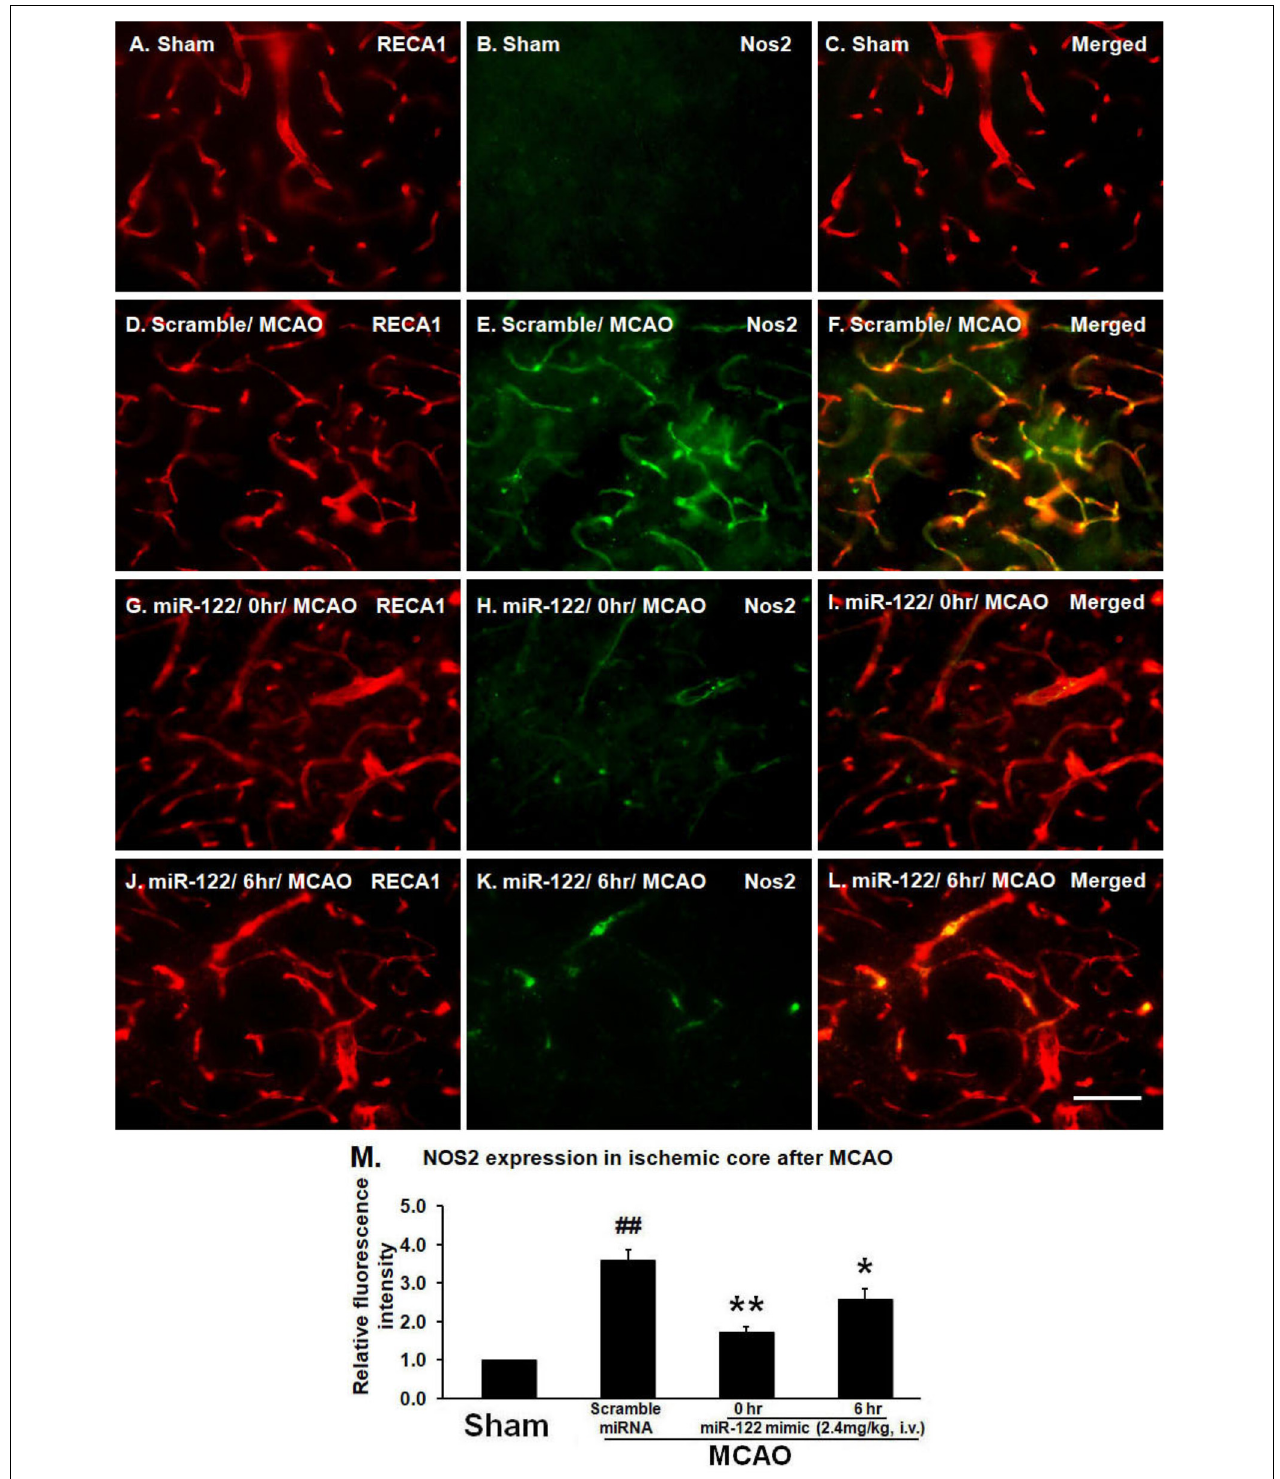
FIGURE 1 | MiR-122 mimic (2.4 mg/kg, i.v., given 0 or 6 h after MCAO) maintains vessel caliber RECA-1 immunoreactivity, but prevents NOS2 induction 24 h after MCAO in rats ( A–C , sham; D–F , scramble MCAO; G–I , 0 h data, J–L , 6 h data). For M , ∗ P < 0.01, ∗∗ P < 0.05 vs. MCAO/Scramble miRNA; ## P < 0.001 vs. Sham. Scale bar: A–L , 50 µ m. n =